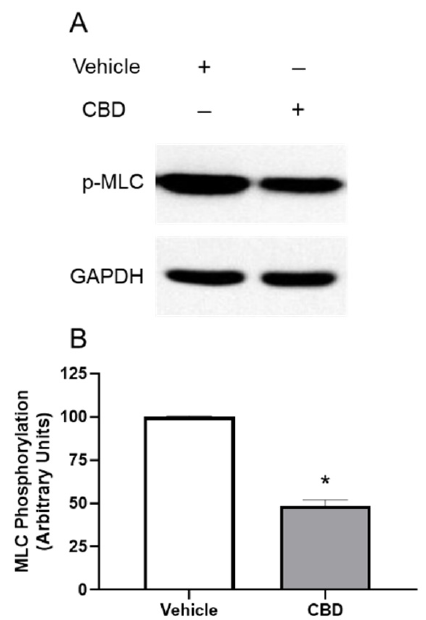
Figure 3. Inhibition of phosphorylation of myosin light chain protein by cannabidiol in trabecular meshwork cells. ( A ): Western blot representative of results obtained in three experiments. Cells were serum starved overnight and treated with vehicle or 1 µM CBD for 2 h, then phosphorylation of myosin light chain (MLC) was measured with anti-GAPDH and anti-phospho-MLC antibodies. ( B ): densitometry quantification of Western blot data from three experiments. MLC is constitutively phosphorylated in vehicle treated TM; following treatment with CBD, MLC phosphorylation signif- icantly decreased. Results are expressed as mean ± SEM ( n = 3). Vehicle treated phosphorylation of MLC levels are normalized to 100%. * Significant difference from vehicle determined by t -test, p <